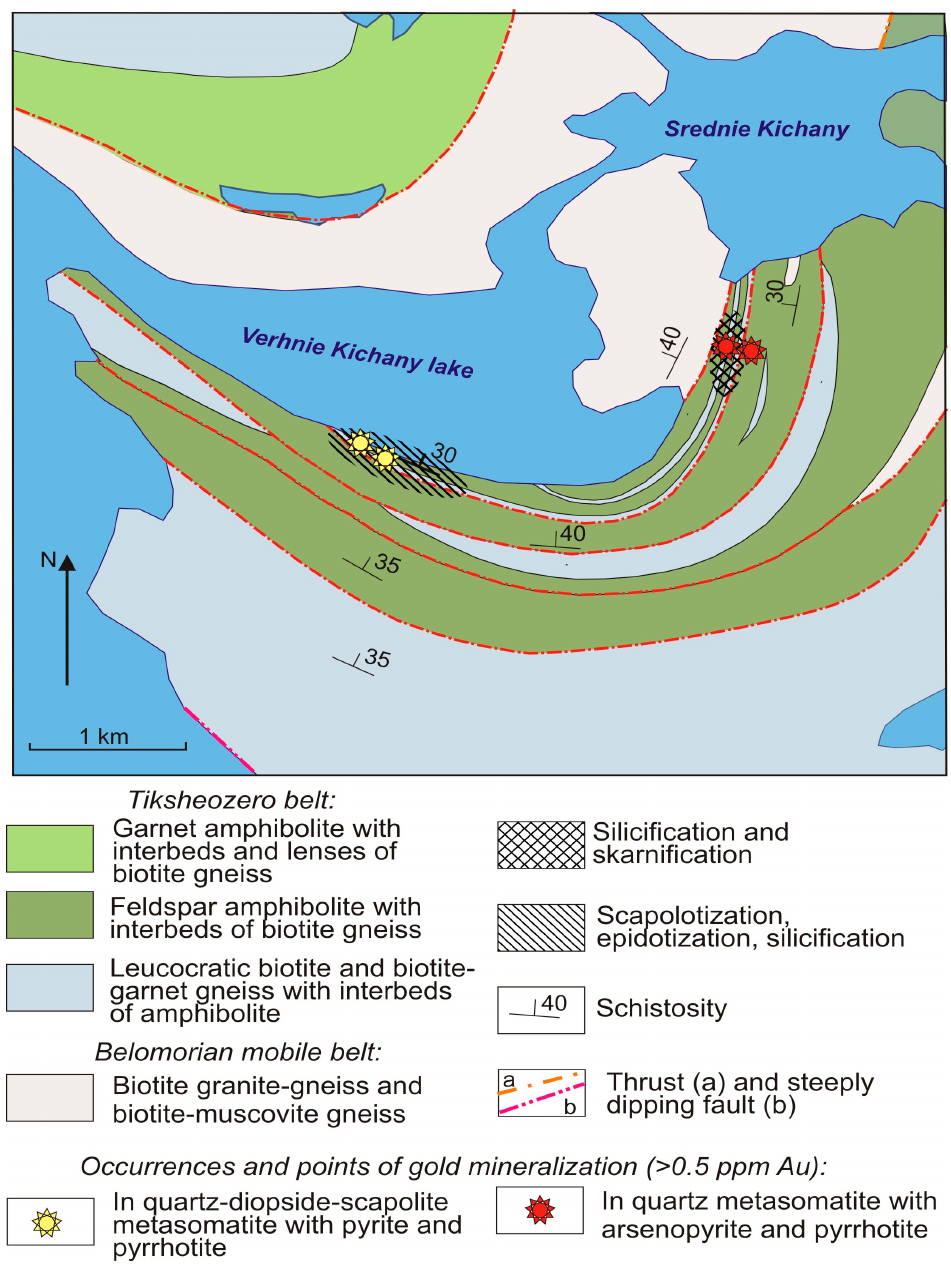
Figure 12. Schematic geological map of the Kichany gold occurrence.